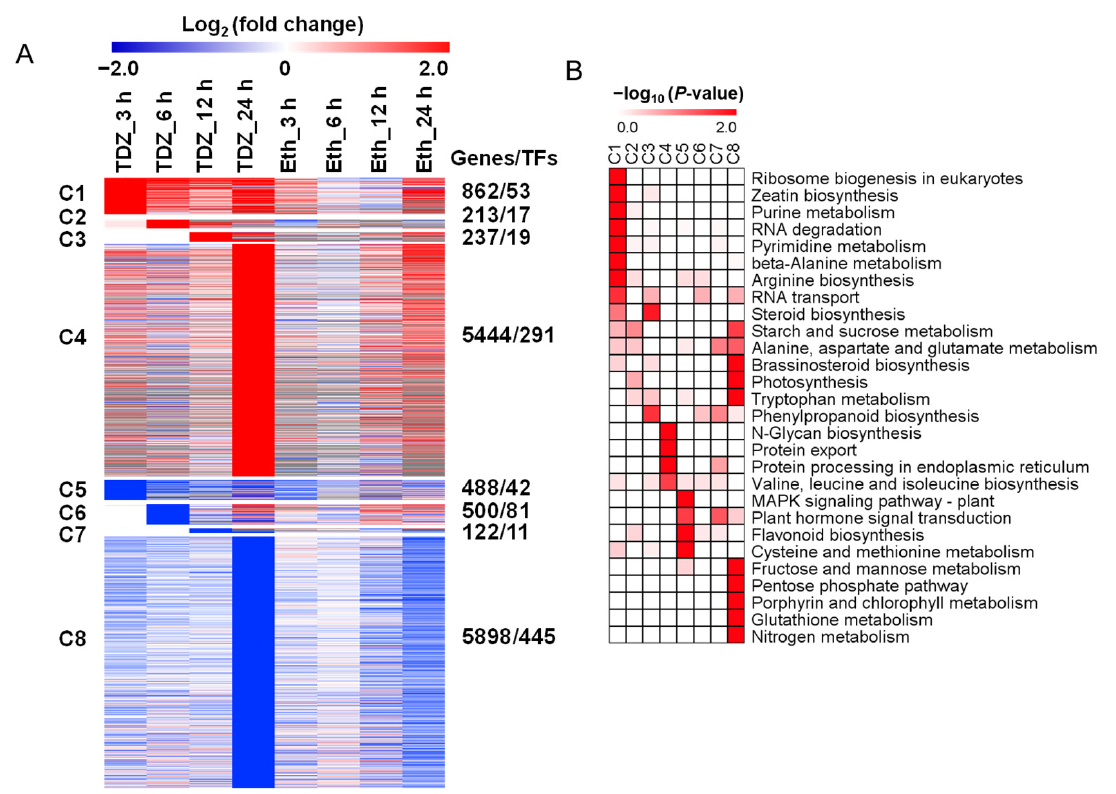
Figure 4. Expression pattern of genes specifically in response to thidiazuron (300 mg/L TDZ) compared with ethephon (0.6 mg/L) (TDZ-SRGs) and functional enrichment analysis over the time course. ( A ) Heat map of the 13,764 TDZ-SRGs over time using log 2 (fold-change) values of genes. The heat map displays expression patterns of the eight clusters, which are grouped by the start time of each gene’s response to TDZ, with red indicating upregulated expression (C1–C4) and blue indicating downregulated expression (C5–C8). ( B ) KEGG functional categories enriched in C1–C8 gene clusters. Significant categories ( p < 0.05) were